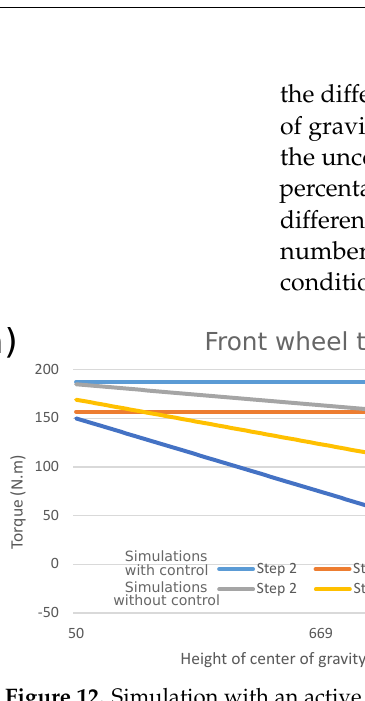
Figure 12. Simulation with an active rear wheel when both the front and the rear wheel are on the edge of a step ( a ) change in required torque on the front wheels with respect to the height of the center of gravity of the load; ( b ) change in required torque on the rear wheel with respect to the height of the center of gravity of the load. Table 6. Statistical analysis of variation in difference of required torque on the front and rear wheels during controlled and uncontrolled conditions with respect to center of gravity of